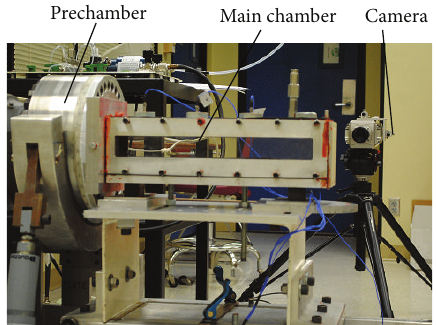
Figure 1: Constant-volume combustor